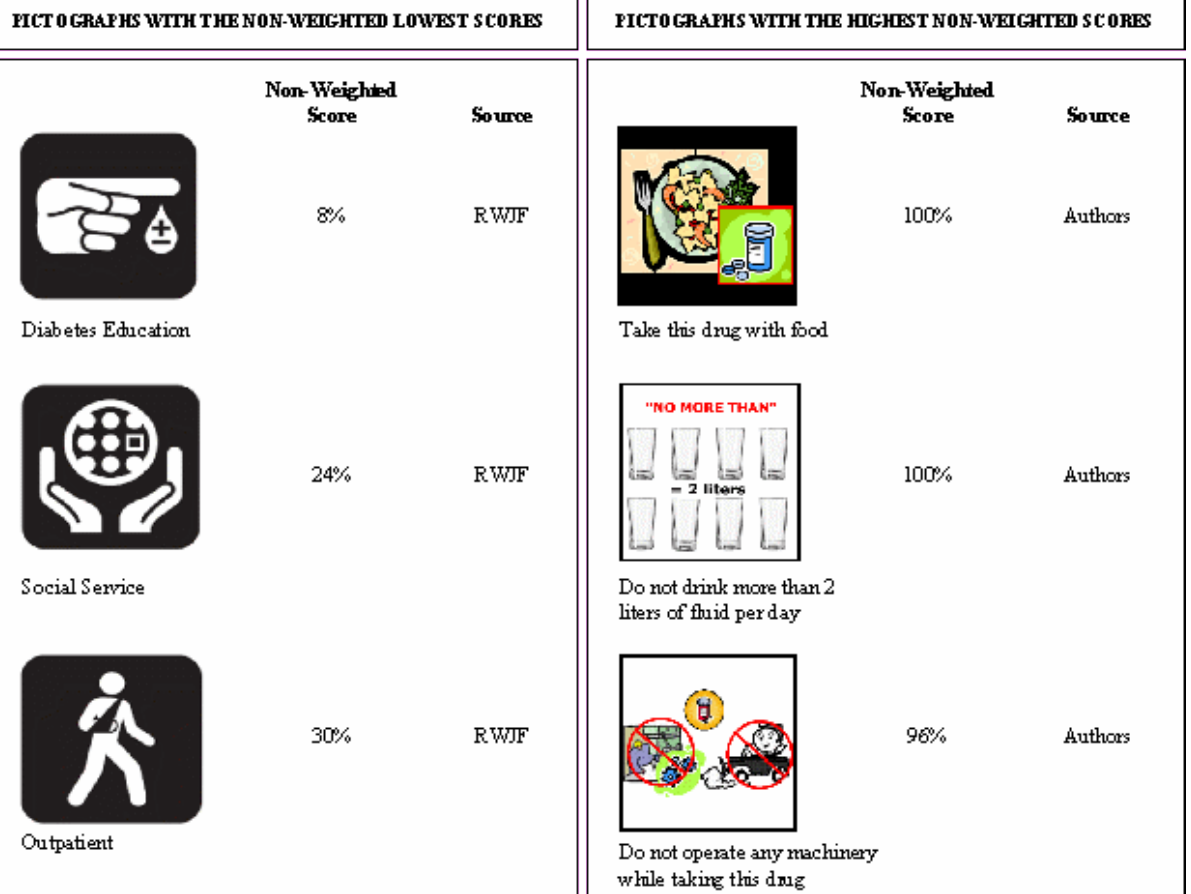
Figure 2. Pictographs with the lowest and highest recognition